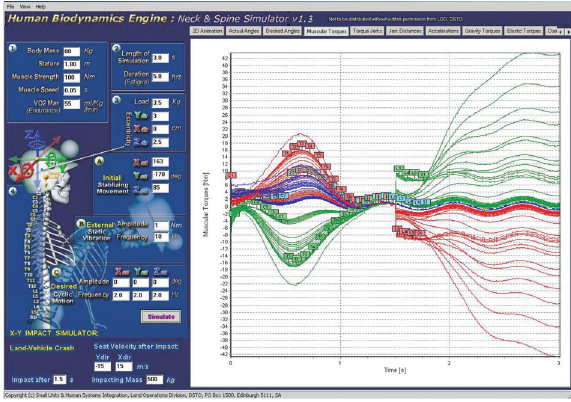
Figure 3.2. The full-spine dynamics and crash HB simulator, implementing the spinal control level: interface and a sample output of muscular torques. Simulating the exponentially stabilizing move- ment (returning to the normal vertical posture from the user-specified head displacement defined by the three initial angles around X , Y , and Z axes), followed by a moderate impact (car crash) at 1 . 5 seconds after the simulation